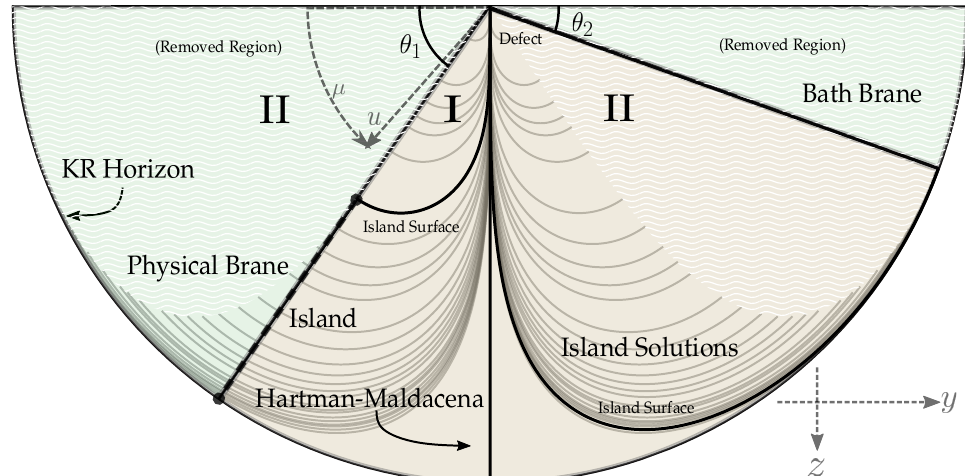
Figure 4: Overview for potential island surfaces within the black string geometry, each of which satisfies the boundary condition for some corresponding brane placed below the critical angle. Each surface ends at its critical anchor, which is where the island begins. One loses the island surfaces as the angle decreases, and the island fills the brane at the critical angle. The area difference between the Hartman-Maldacena surface and the island surface vanishes slightly below the critical angle. While one would need many digits of precision to show this, the island surfaces appear to fill the island commonwealth , labelled as region I, without crossing one another. They never make it into the region II, which we call independent territory